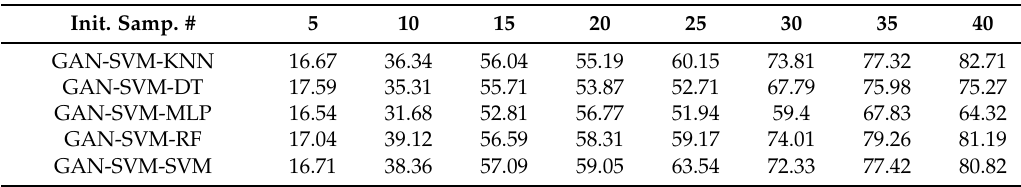
Table 2. The fault diagnosis accuracy rates (%) with different classifiers using GAN-SVM to generate artificial training dataset.